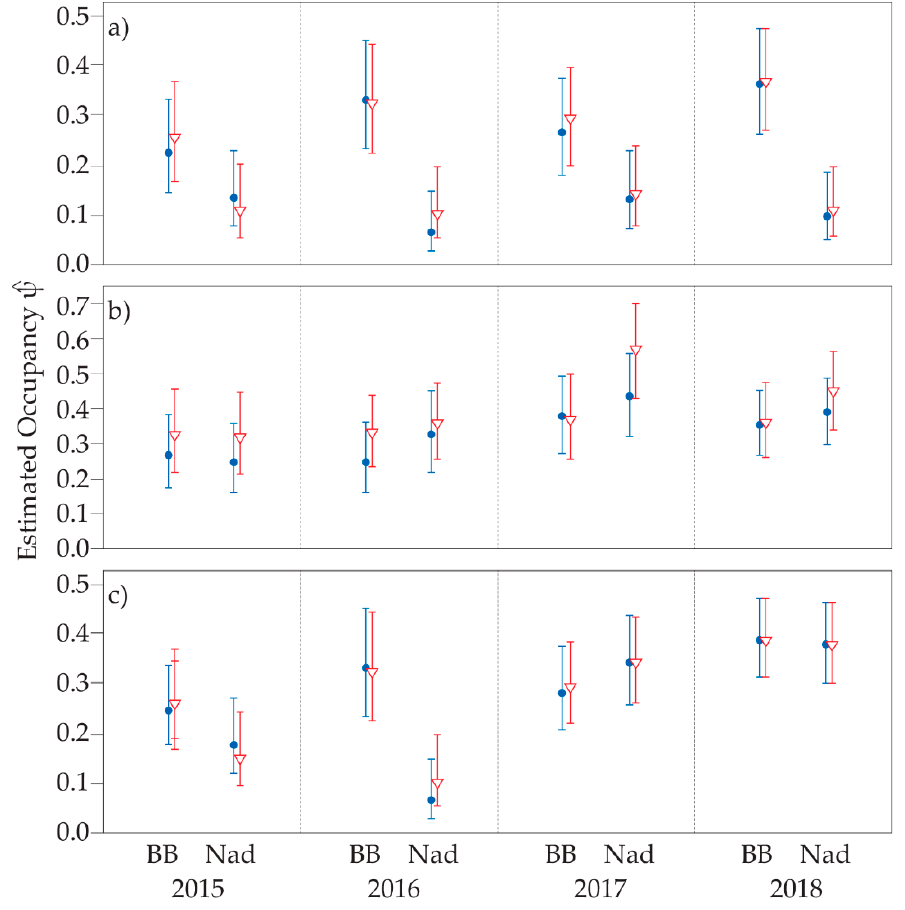
Figure 5. Single-season occupancy for ( a ) Isoodon , ( b ) Perameles , and ( c ) Potorous in Ben Boyd (BB) and Nadgee (Nad). Estimates are based on a 30-day survey period (blue) and 40-day survey period (red). Central mark represents the predicted estimate and bars represent the 95% confidence interval. Note that with the exception of occupancy estimates for Perameles in 2017, duration of camera-trap deployment had little effect on outcomes.